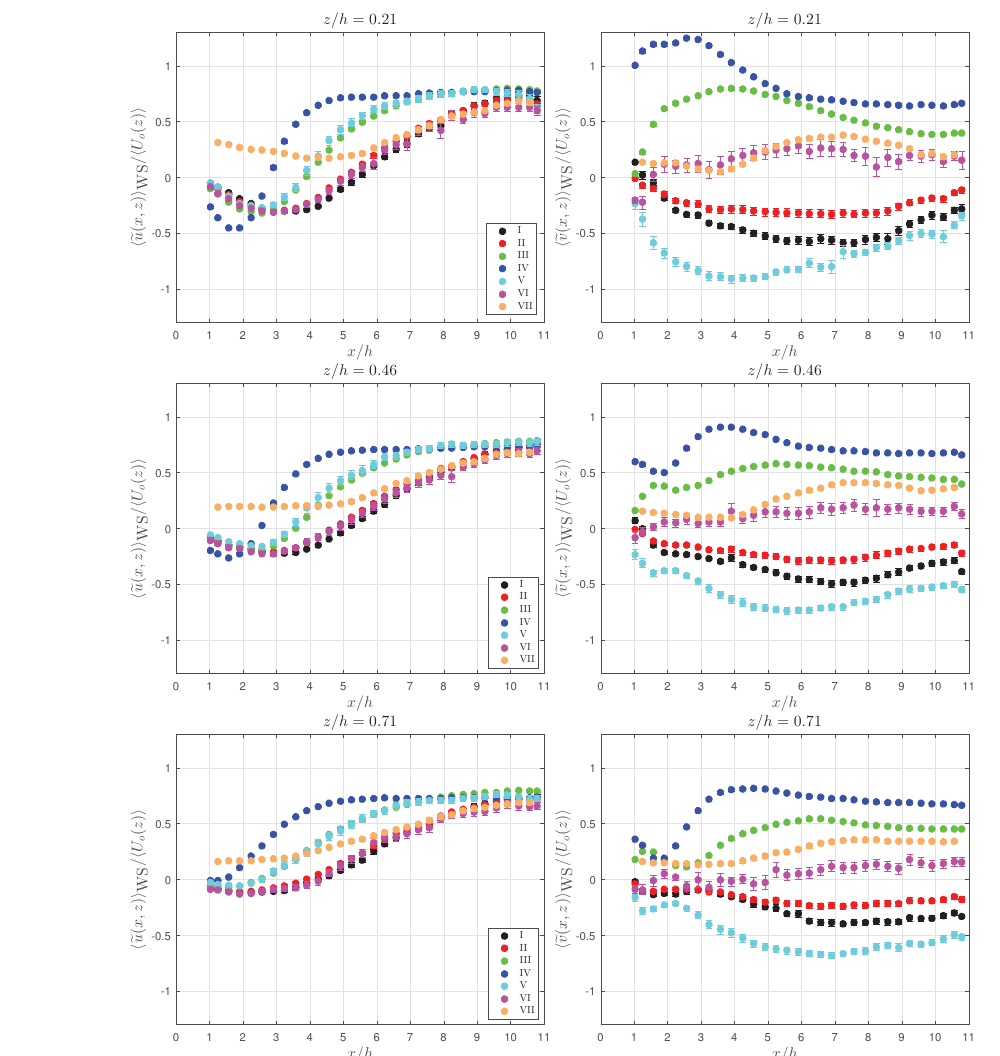
Figure 9. Averaged wind-speed ratio (separated into the u and v components) on the first three verticals level behind the fence for a number of cases. ± the standard error is shown in the error